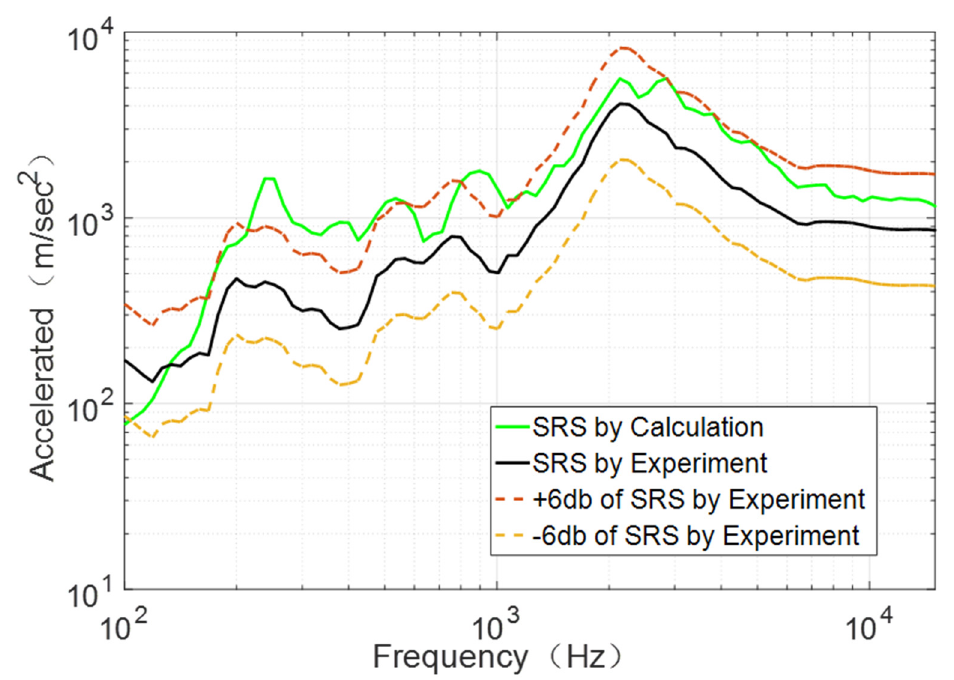
Figure 11. Shock responses of experiment and calculation for plate 2.